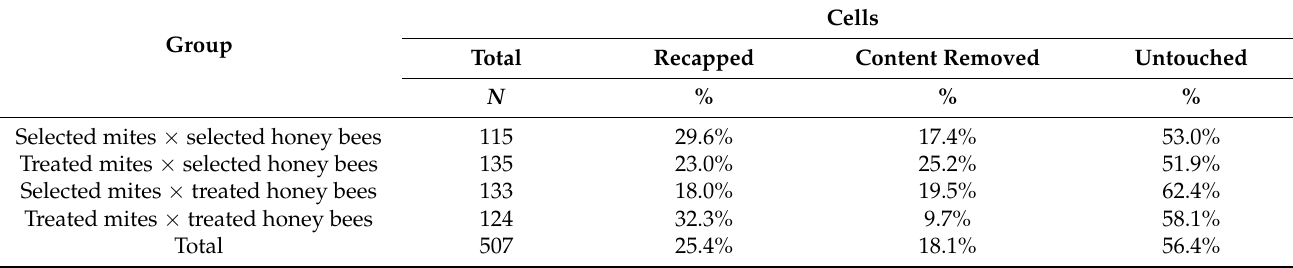
Table 1. Fully-crossed infestation field experiment with mites, Varroa destructor , and worker brood cells from both selected and treated honey bee, Apis mellifera , colonies. The total number of cells experimentally infested with foundress mites and the numbers and proportions (%) of cell recapping, brood removal and untouched cells are shown for the four groups. Group